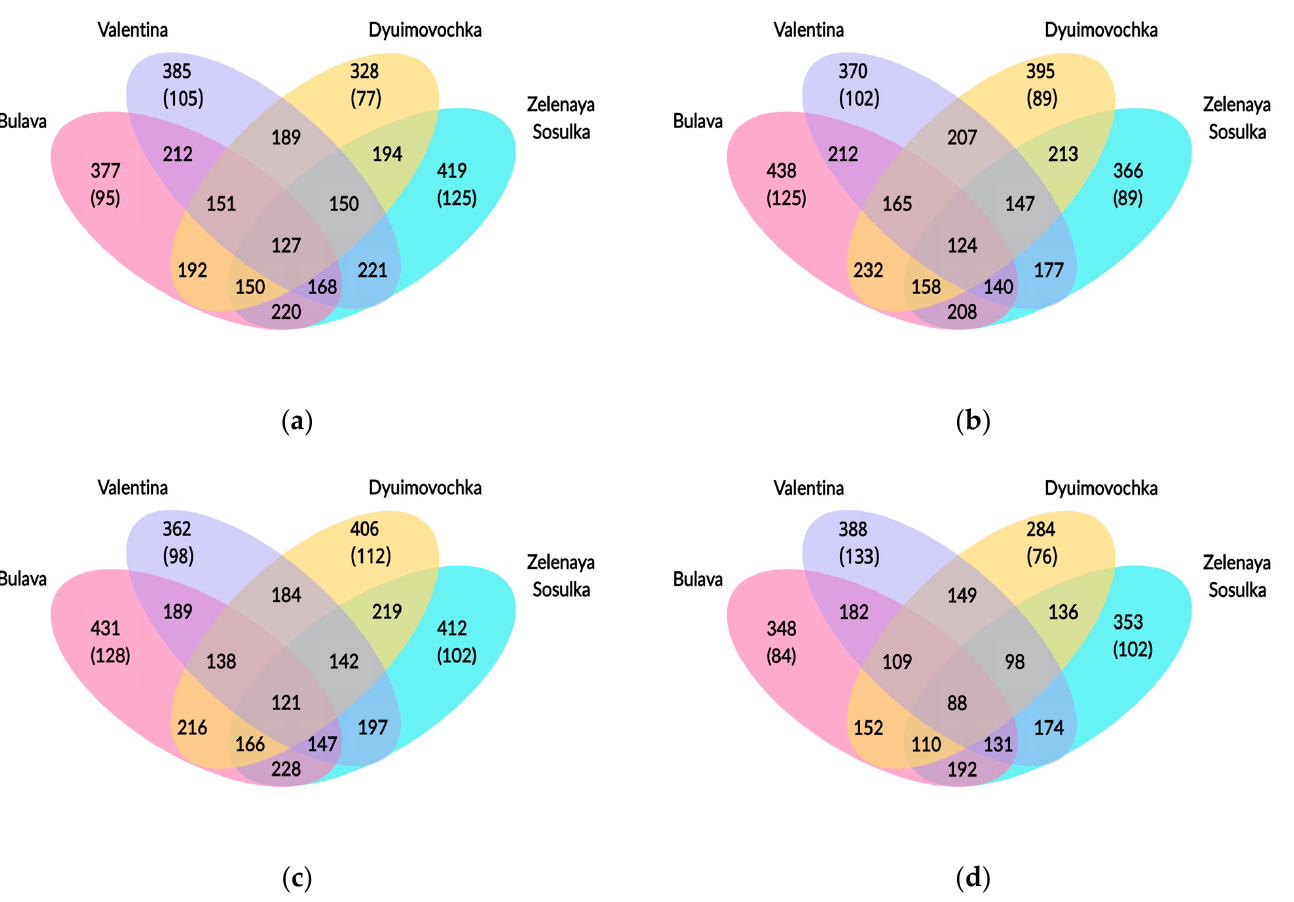
Figure 4. Venn diagram depicting shared and unique OTUs among the rhizosphere microbial communities of the amaranths grown on the background and polluted soils. The number of unique taxa